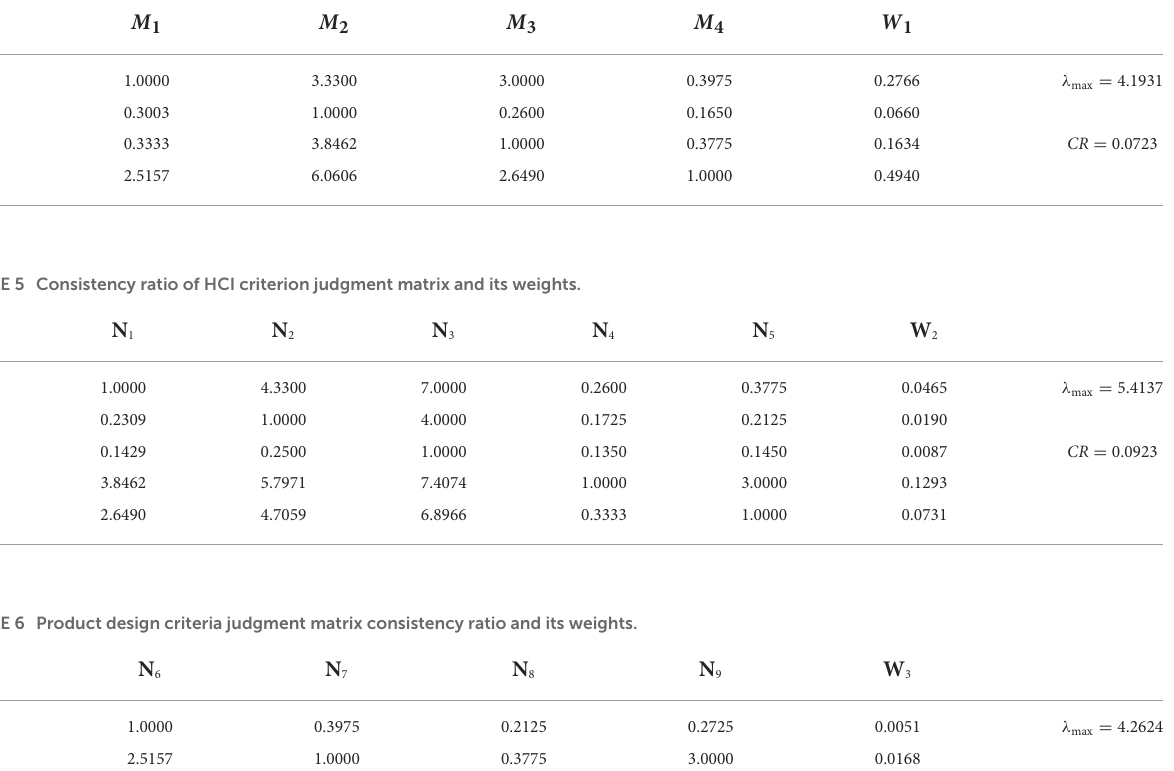
TABLE 4 Consistency ratios of the first-level criterion judgment matrix and their weights.